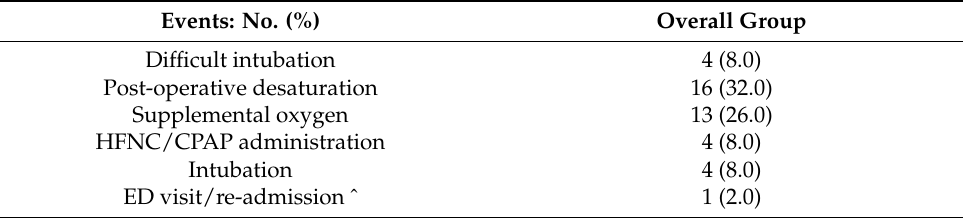
Table 1. Adverse perioperative respiratory events of the cohort (n = 50).